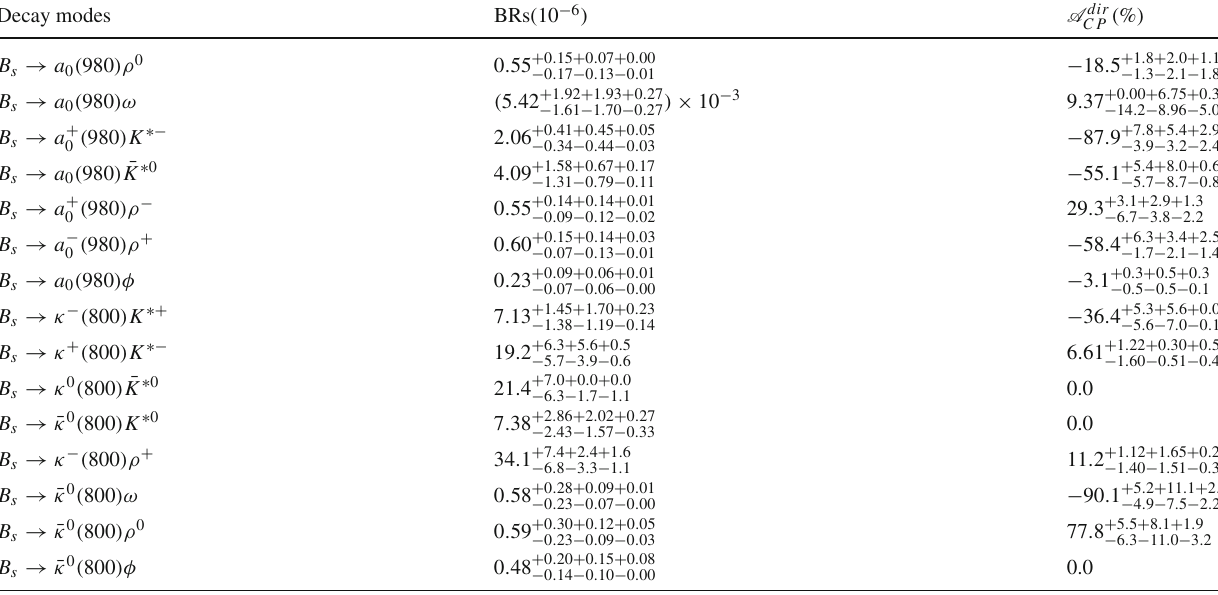
Table 2 The CP averaged branching fractions and the direct CP asymmetries of the B s → a 0 ( 980 ) [ κ( 800 ) ] V decays in S-I Decay modes